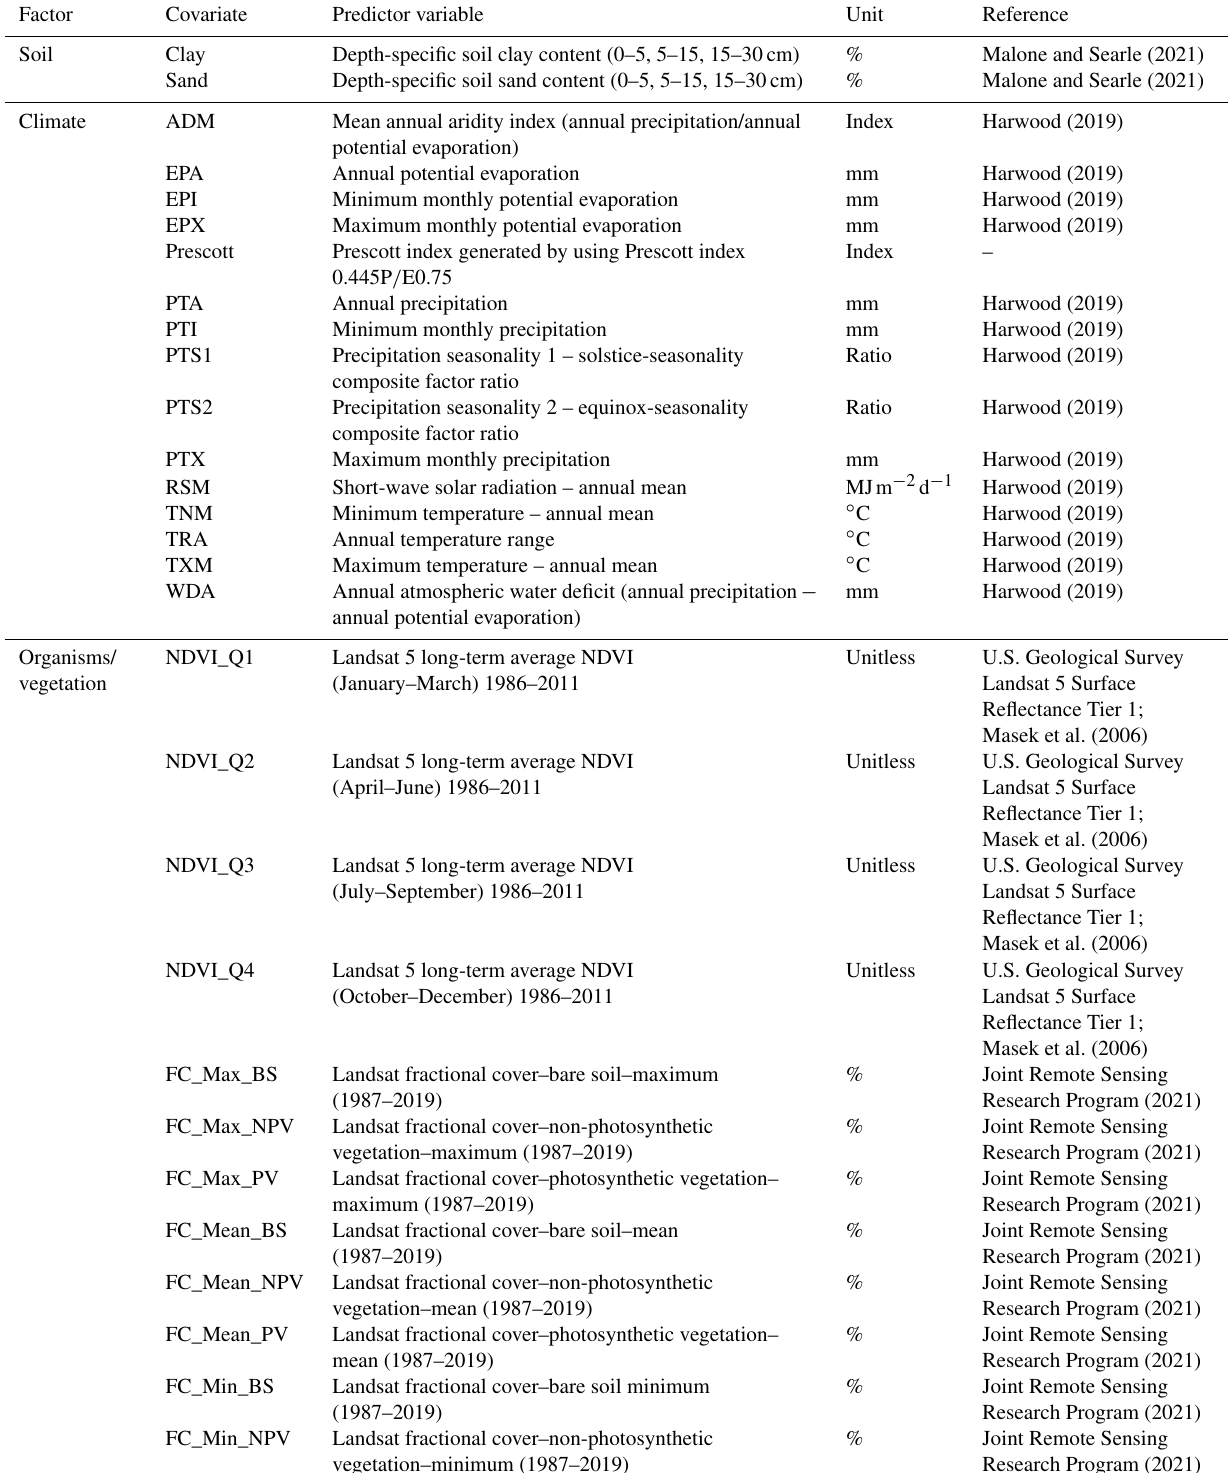
Table 1. List of environmental covariates with unit and associated reference when applicable. All covariates are in geographic coordinates with a 3arcsec grid-cell (about 90m × 90m) resolution with coordinate system WGS84 (EPSG:4326) and extent 10.0004–44.00042 ◦ S, 112.99958–153.99958 ◦